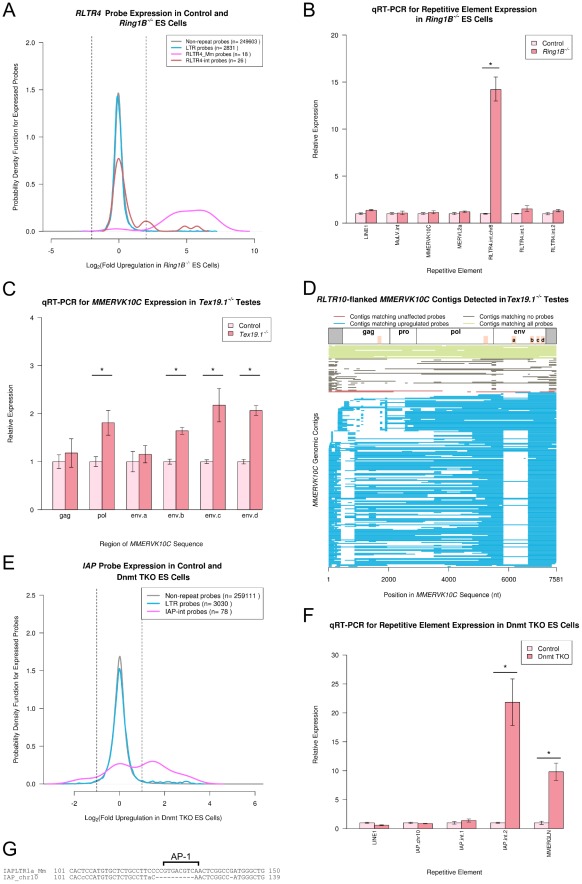
Differential regulation of retrotransposon genomic loci.(A) Plot showing the differential behaviour of different RLTR4 retrotransposon probe populations in Ring1B−/− single knockout ES cells. Different RLTR4 probe populations are colour-coded as shown in the legend, and vertical lines indicate a 4 fold change. (B) qRT-PCR verification of repetitive element expression in Ring1B−/− ES cells. Expression levels (mean ± standard error) were normalized to β-Actin and expressed relative to wild-type control ES cells. MMERVK10C env.c and LINE1 5′UTR primer sets (Figure S2) were used to assess MMERVK10C and LINE-1 expression. The asterisk indicates a statistically significant difference (p<0.05). Note that different primers for RLTR4 elements behave differently in the qRT-PCR assay. (C) qRT-PCR for different MMERVK10C primer sets in Tex19.1−/− knockout and littermate control testes at 16 dpp. Expression levels (mean ± standard error for three animals) were normalized to β-Actin and expressed relative to littermate controls. Asterisks indicate statistically significant differences (p<0.05) (D) Plot showing the MMERVK10C genomic contigs flanked by RLTR10C LTRs that match only upregulated probes (blue), only unaffected probes (brown), neither class of probes (grey), or both classes of probe (green) in Tex19.1−/− testes. Each contig is represented by a horizontal line that indicates the regions of the MMERVK10C sequence within it. The upregulated MMERVK10C contigs appear to contain recurrent deletions and may be non-autonomous. The positions of the qRT-PCR primers used in (C) are shaded orange. (E) Plot showing the bimodal behaviour of IAP-int retrotransposon probe populations in Dnmt TKO ES cells. Vertical lines indicate a 4 fold change. (F) qRT-PCR for of repetitive elements in Dnmt TKO ES cells. Expression levels (mean ± standard error) were normalized to Gapdh and expressed relative to wild-type control ES cells. The asterisk indicates a statistically significant difference (p<0.05). The LINE1 5′UTR.b primer set (Figure S2) was used to assess LINE-1 expression. Note the difference in behaviour between the two IAP-int primer sets. The IAP contig carrying deletions in the AP-1 binding site shown in panel G (IAP_chr10 primers) is expressed but not upregulated in Dnmt TKO ES cells. (G) Sequence alignment between an LTR of a full-length IAP element that does not change expression in Dnmt TKO ES cells (IAP_chr10), and the consensus sequence for the LTR (IAPLTR1a_Mm). The 10 bp deletion removes the AP-1 transcription factor binding site in the LTR.